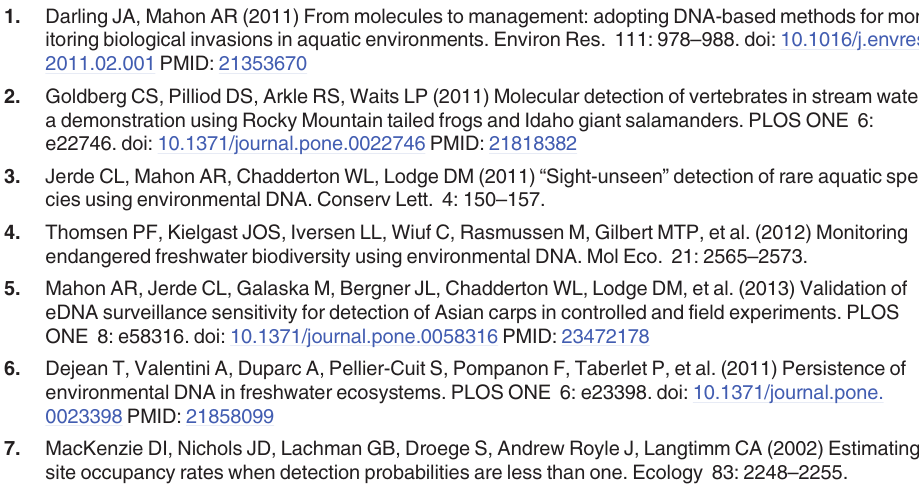
S2 Table. Regional Bayesian estimates of occurrence ( ψ ) and detection ( p ) probabilities of Python molurus bivittatus environmental DNA. Posterior mean and 95% credible interval (CI) are given for each parameter of the occupancy model. A uniform prior distribution was as- sumed. Average conditional probability of occurrence of Burmese python eDNA in a single (cid:2) y sample ( ). Cumulative probability of detecting eDNA in three qPCR replicates ( p (cid:3) ). BDB, Bird Drive Basin; DE, Deering Estates; ENP, Everglades National Park; HLWM, Holey Lands Wildlife Management Area; STA, Stormwater Treatment Area 5; and radiotagged snakes: ELV, Elvis; NOS, Noosa; and SWP, Sweet